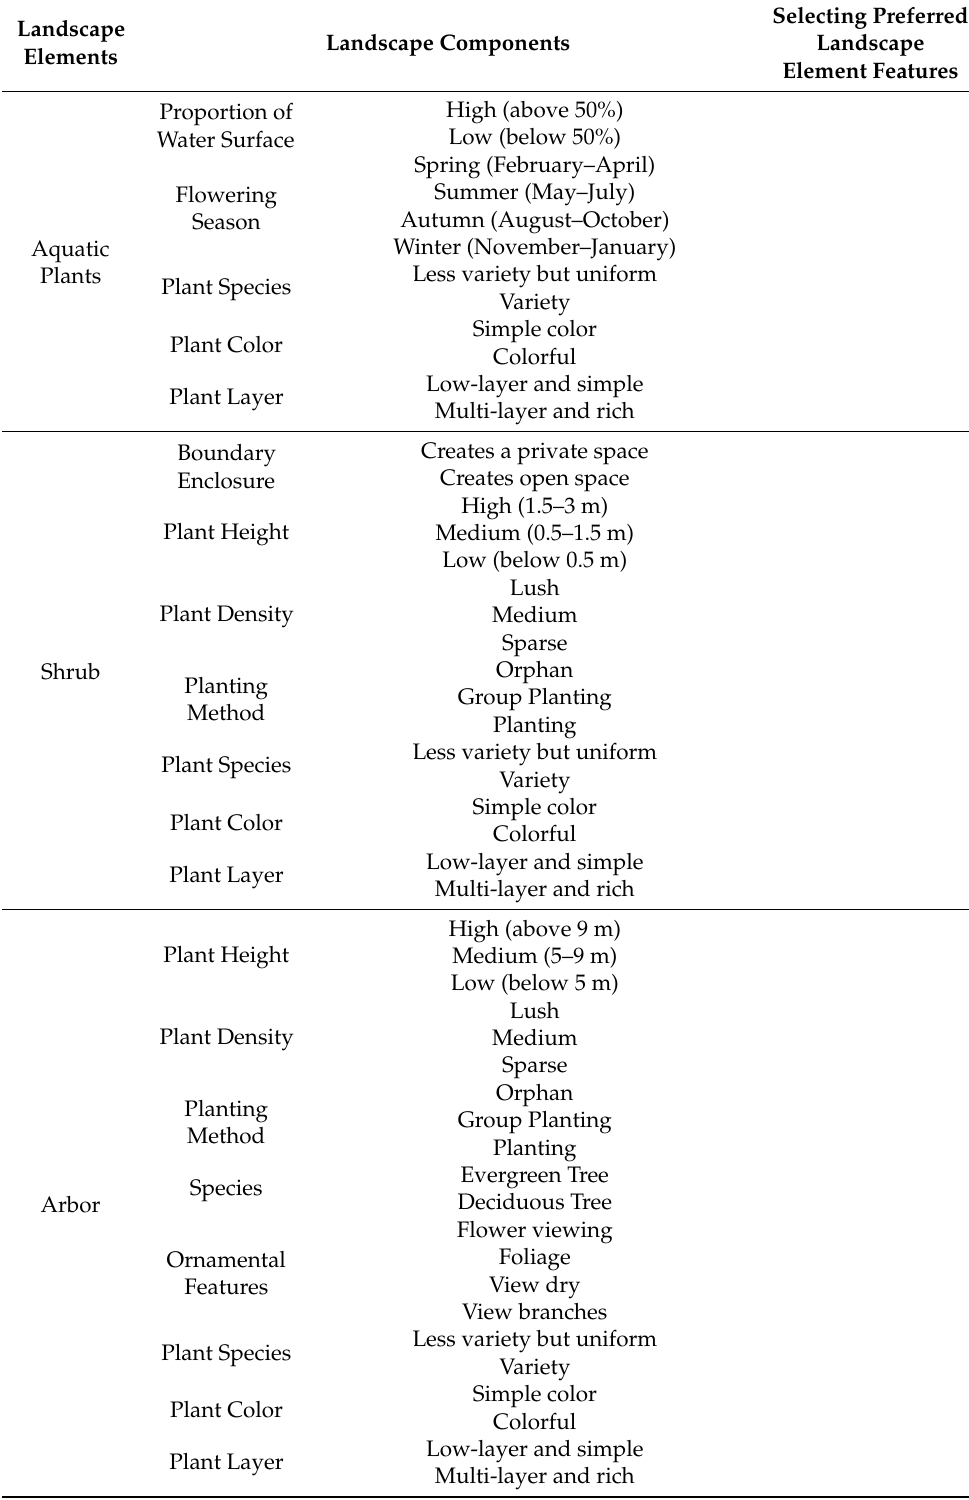
Table A2. Campus Landscape Preference Factor Scales of Jiuqu